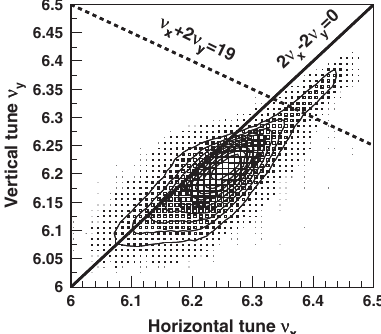
FIG. 33. Tune footprint at the end of injection calculated with ϵ 150 π mm mrad for the beam intensity of 850 kW. tp ¼